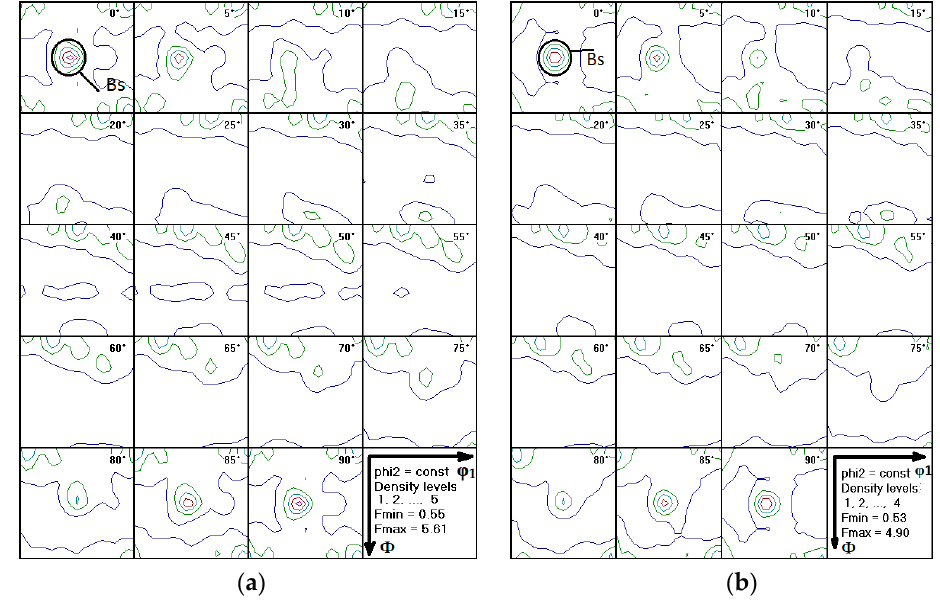
Figure 16. ODF for the state after annealing, ( a ) 350 ◦ C and ( b ) 500 ◦ C with 1-h exposure. After cold rolling and annealing at 500 ◦ C, the AlMg 6 Mn 0.7 (1565 ch) alloy has almost